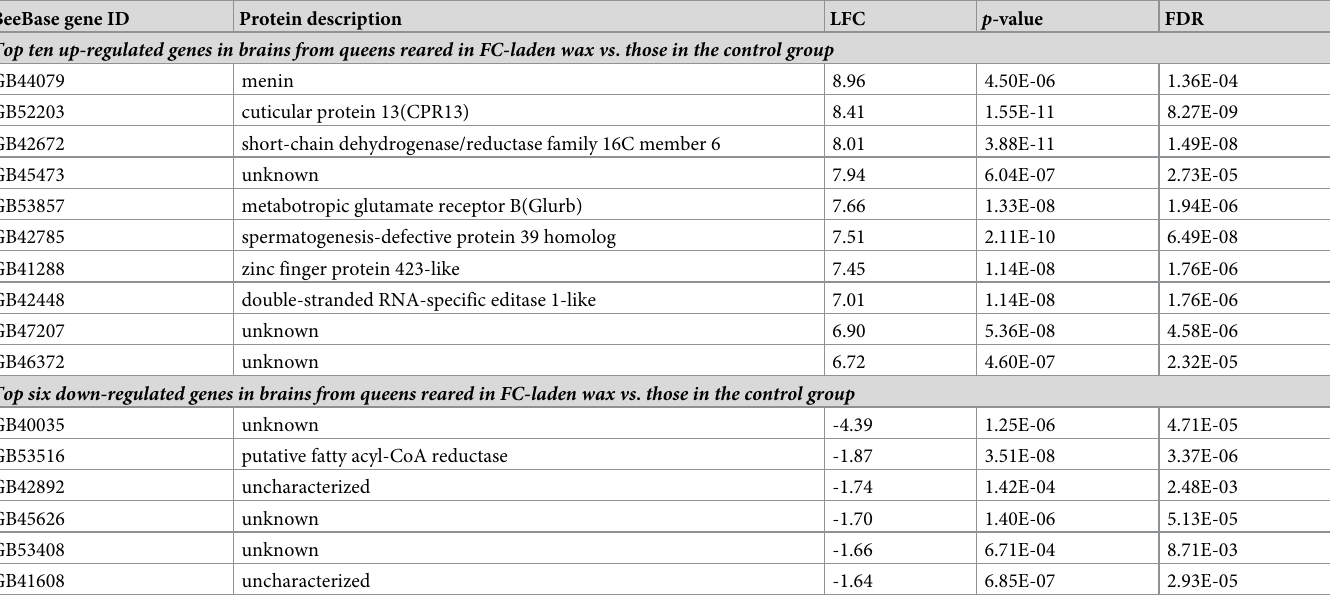
Table 1. The top ten and bottom six genes that were differentially expressed in brain tissue from queens reared in wax contaminated with a mix of tau -fluvalinate and coumaphos ("FC") compared to those reared in untreated wax (control group), ranked by their log 2 fold change (LFC). "FDR" is the false discovery rate. BeeBase gene ID Protein description LFC p -value Top ten up-regulated genes in brains from queens reared in FC-laden wax vs . those in the control group